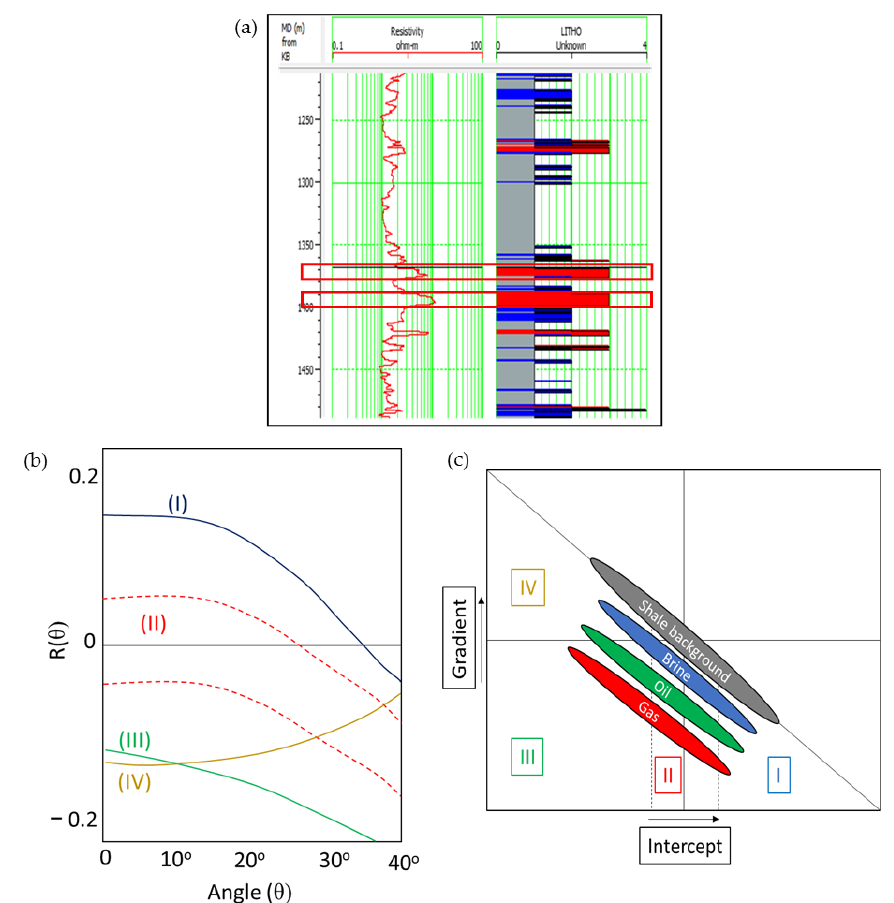
Figure 5. ( a ) Characteristic of resistivity log for gas sand reservoir at study area, which was highlighted by red rectangles, ( b ) AVO response for class 1, 2, 3, and 4, and ( c ) AVO classes of a seismic reflection based on AVO cross plot.